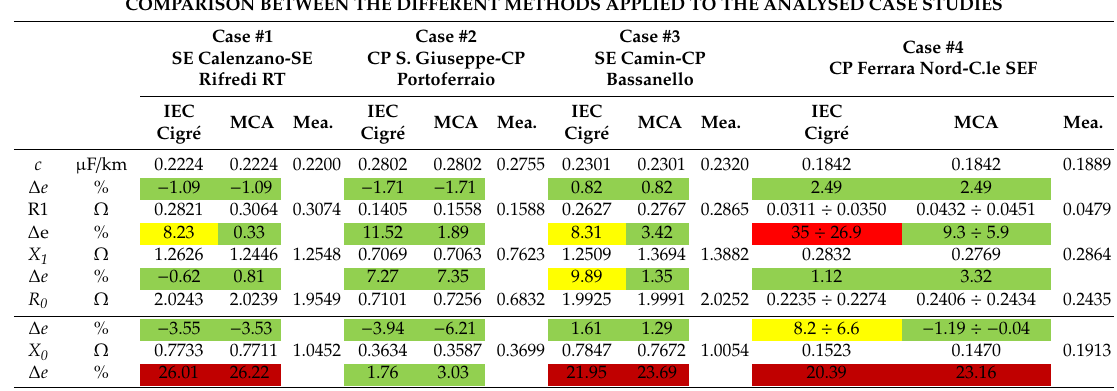
Table 13. Final comparisons of the measurements with MCA and IEC / Cigr é computations. COMPARISON BETWEEN THE DIFFERENT METHODS APPLIED TO THE ANALYSED CASE